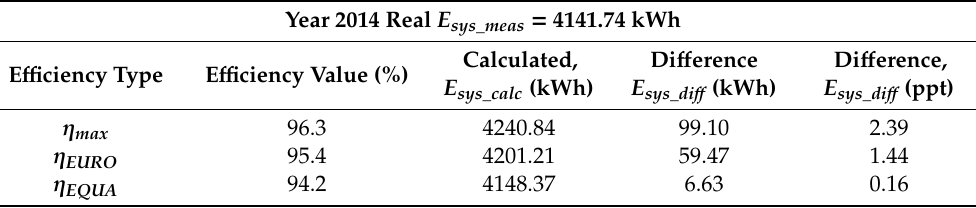
Table 11. Validation results of E sys with di ff erent types of PV inverter e ffi